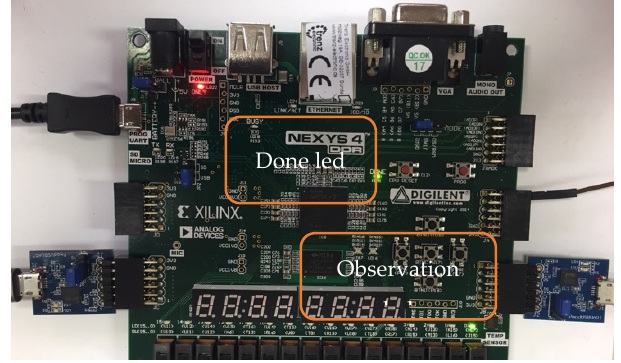
Figure 17. Device programmed with SEM IP observation mode (H17 led).